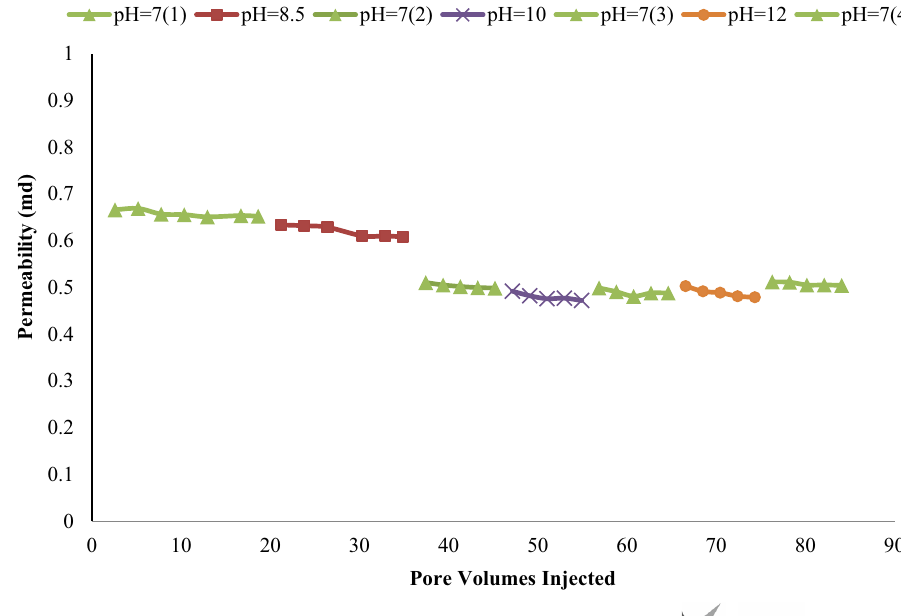
Fig. 4 The permeability altera- tion during injection of different alkaline fluids in core no.1